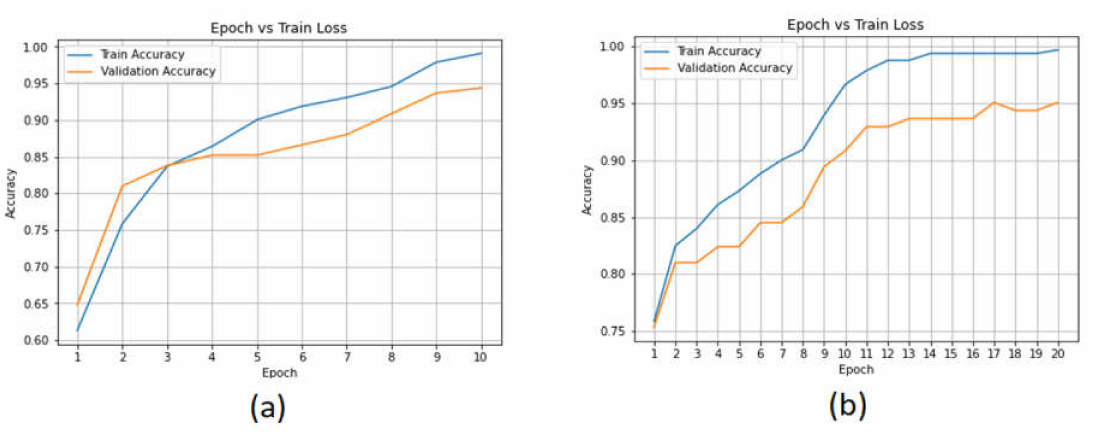
Figure 13. Performance of the deep learning models with the CICAndMal2017 dataset. ( a ) LSTM. ( b ) CNN-LSTM.